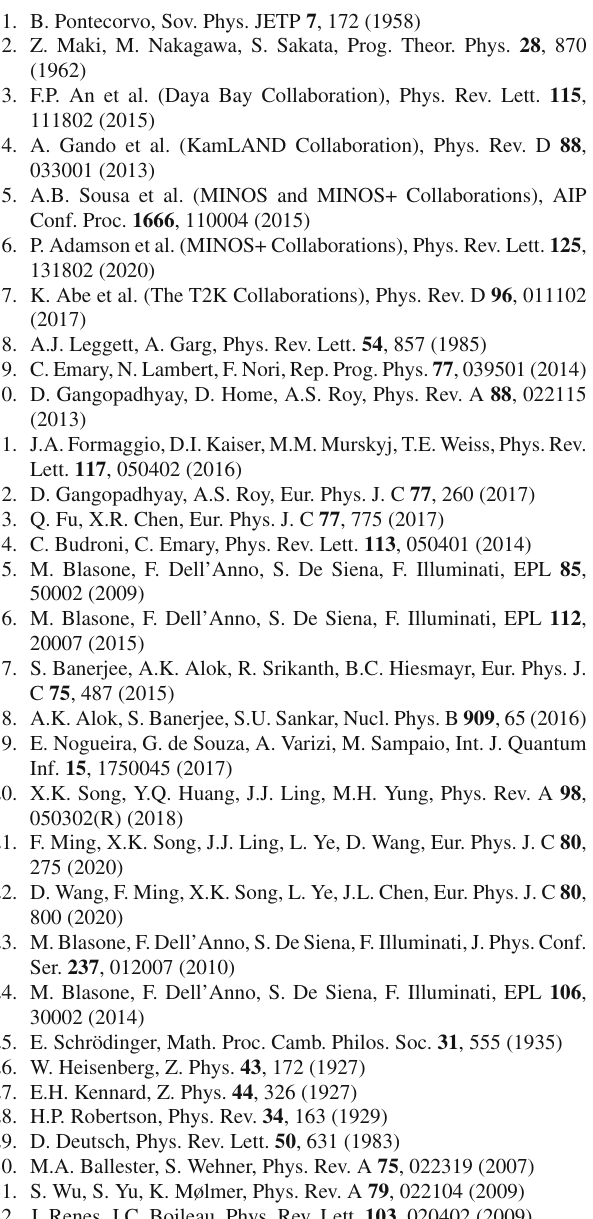
world, the entropy-based uncertainty and the entanglement of system intrinsically exhibit an anti-correlation relation in neutrino oscillations, implying that the stronger entangle- ment will lead to the smaller uncertainty, and vice